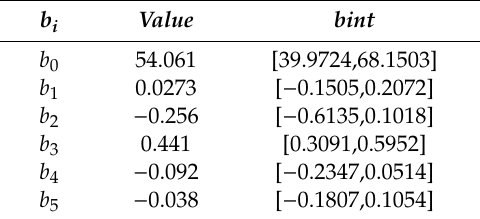
Table 4. New regression coe ffi cient interval.